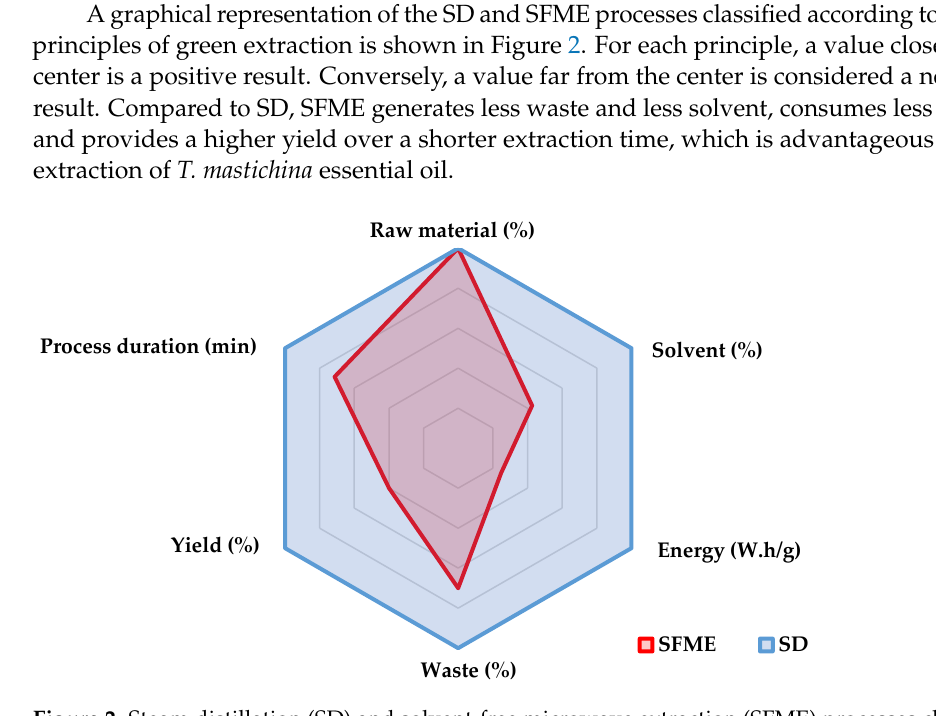
Figure 2. Steam distillation (SD) and solvent-free microwave extraction (SFME) processes classified according to the six principles of green